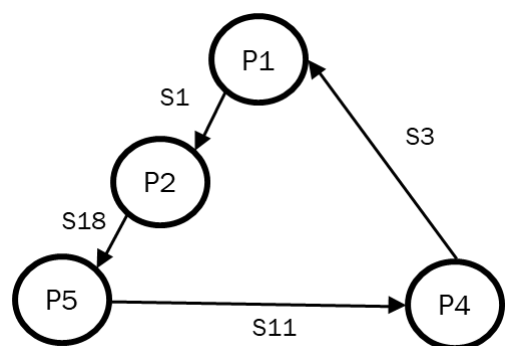
Table 10. Map of the index of each vertex and its 3D value for Scenario 3.